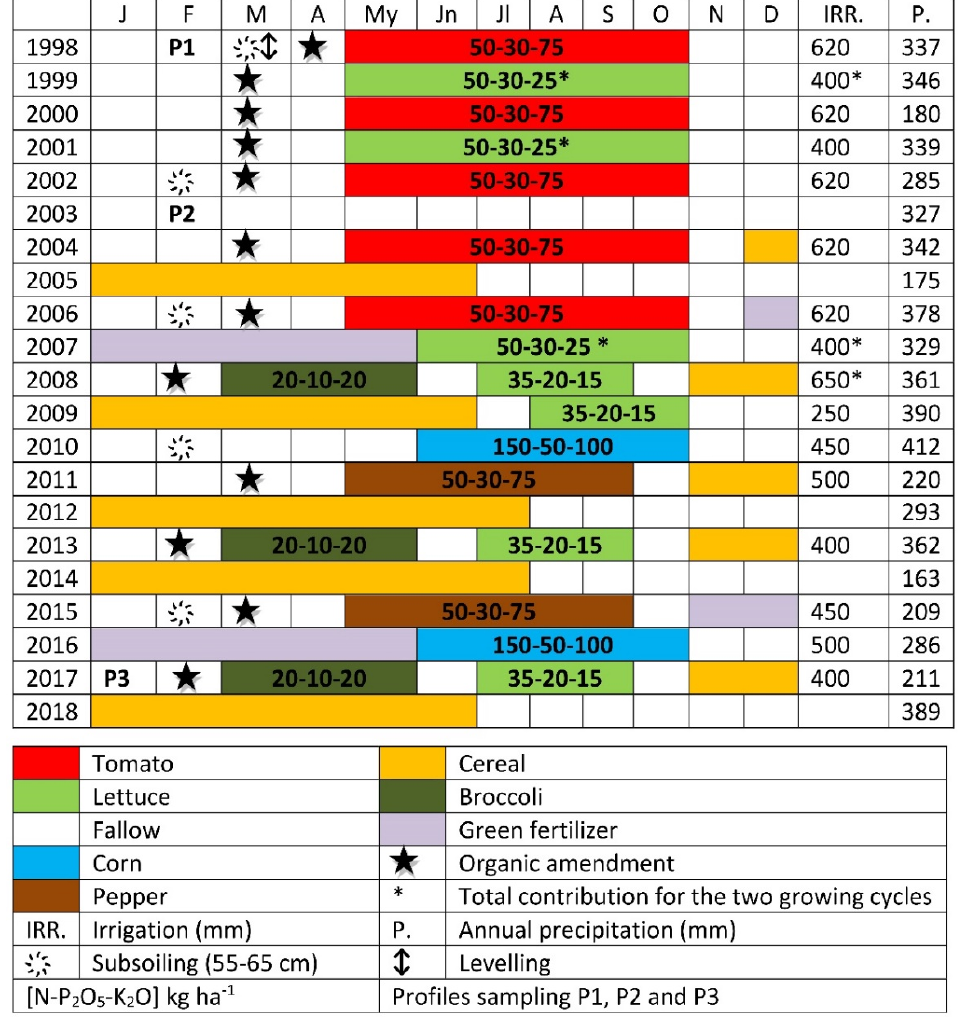
Figure 2. Chronogram. The cycle of the different crops, fallow periods, green fertilizer and fertilizer units (N-P 2 O 5 -K 2 O) applied, organic amendment, irrigation, and annual precipitation during the research period.